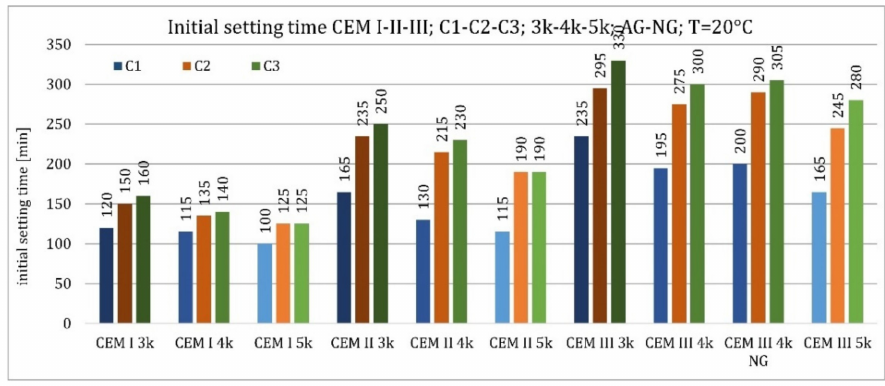
Figure 6. Initial setting time of non-modified cements CEM I, CEM II/B-S, CEM III/A at 20 ◦ C.